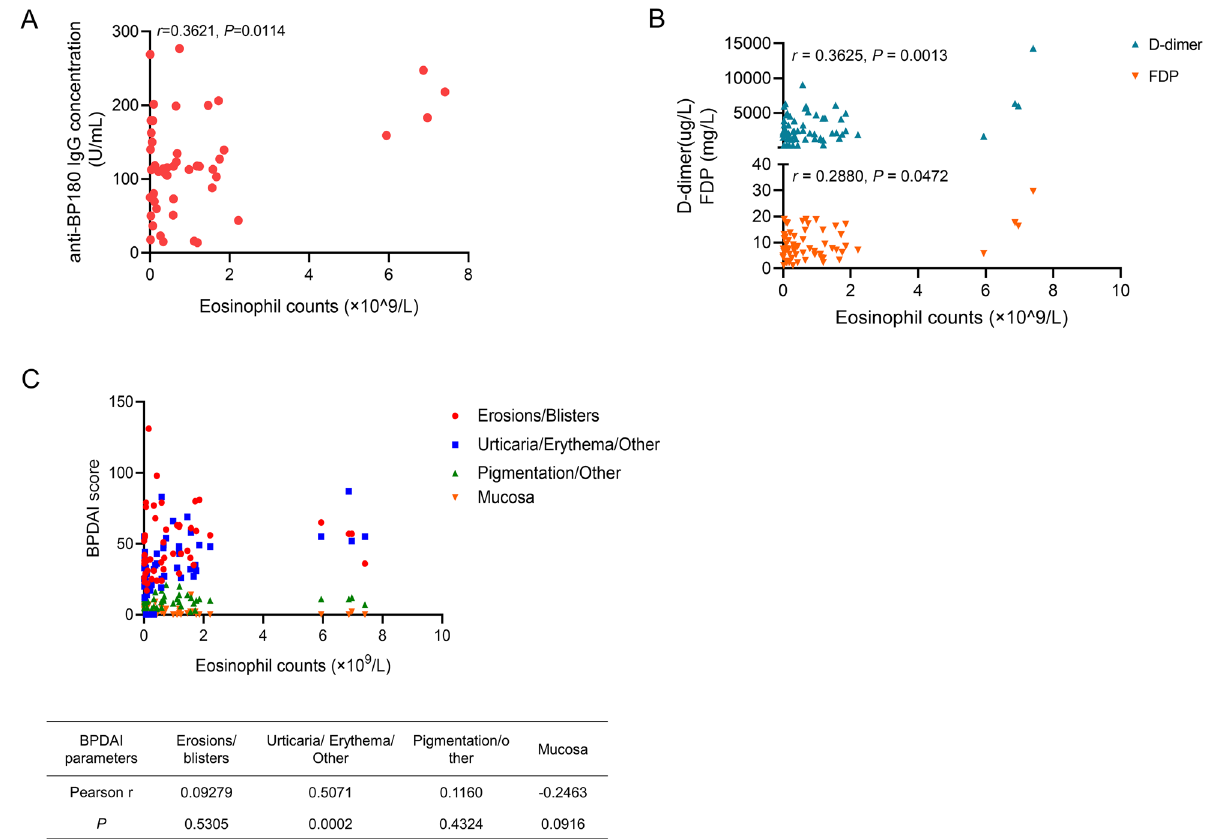
Figure 3. The correlation among eosinophil counts, anti-BP180 IgG concentrations, D-Dimer, FDP, and BPDAI. ( A ) The correlation between eosinophil counts and anti-BP180 IgG concentration; ( B ) The correlation of eosinophil counts and levels of D-dimer and FDP; ( C ) The correlation between eosinophil counts and BPDAI indexes.